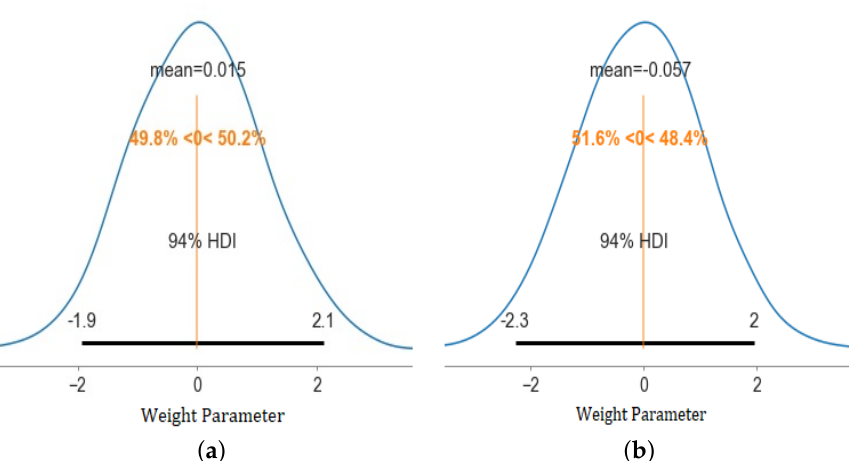
Figure 3. ( a , b ) An instance of the posterior probability distribution of the weight parameter for the Bayesian CNN and BNN, respectively. Both were obtained during an iteration of the models’